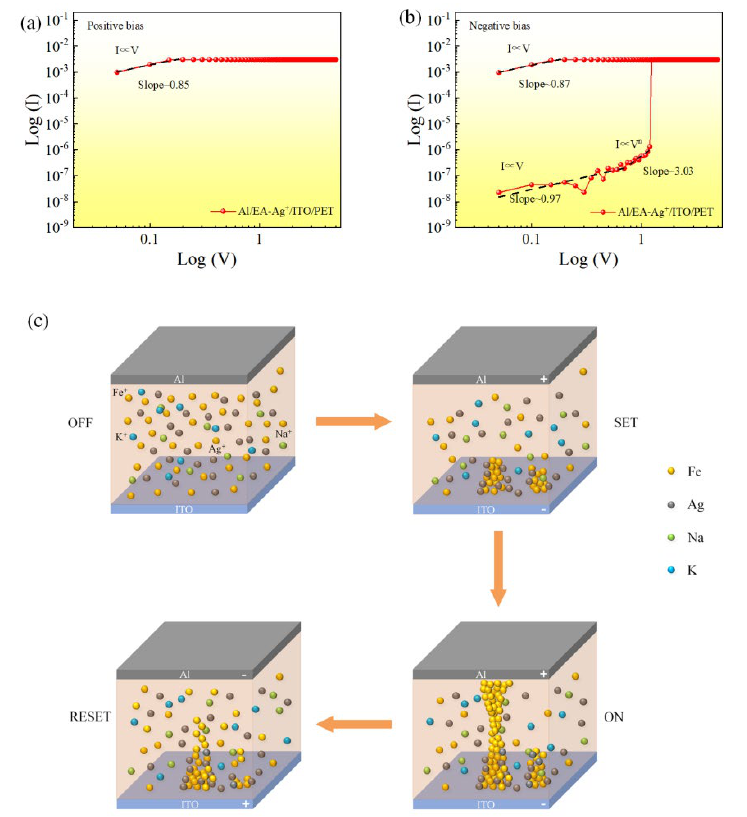
Figure 5. ( a , b ) I–V curves on a log–log scale for the Al/EA:Ag + /ITO structure. The scatters are experimental data, and the straight lines are the fitting curves from theoretical models. ( c ) Diagram of the conduction mechanism.